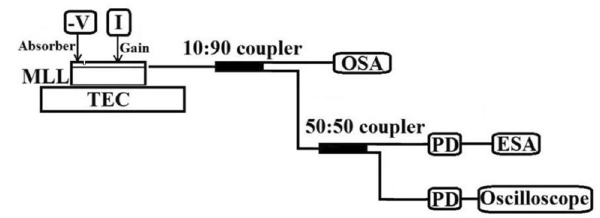
Figure 2. Schematic diagram of the MLL measurement setup.